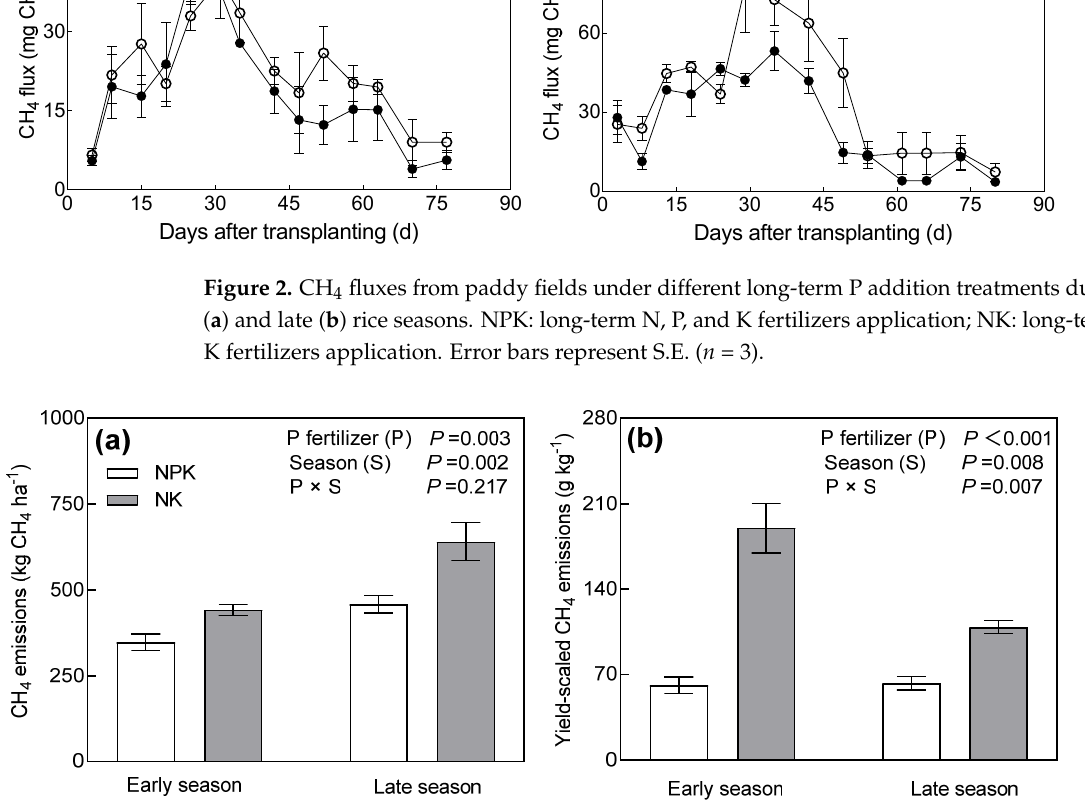
Figure 3. Cumulative CH 4 emissions ( a ) and yield-scaled CH 4 emissions ( b ) under different long-term P addition treatments during early and late rice seasons. NPK: long-term N, P, and K fertilizers application; NK: long-term N and K fertilizers application. Error bars represent S.E. ( n = 3).